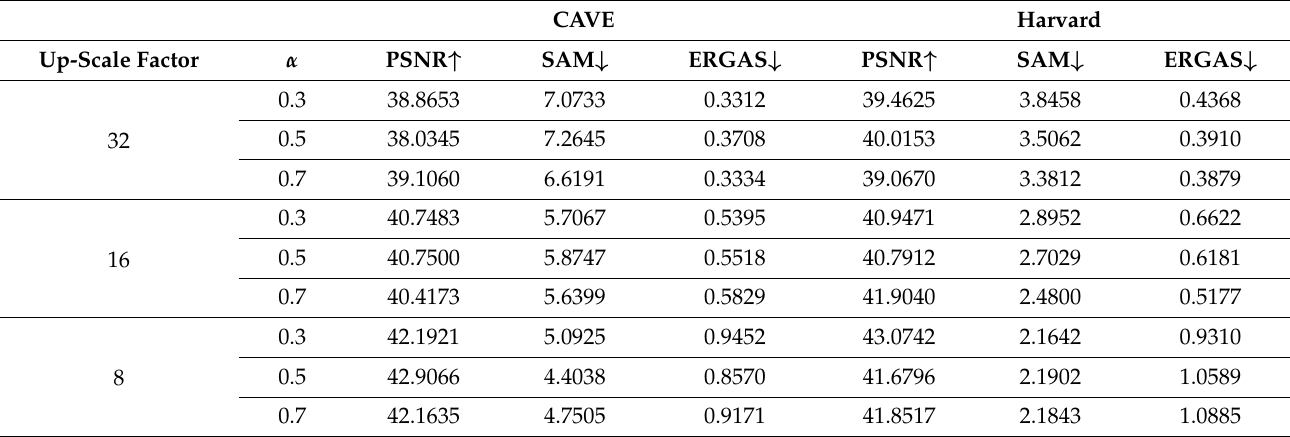
Table 4. Comparison of the evaluation results using our proposed method: DUFL+ with different weights α values of 0.3, 0.5 and 0.7 in the CAVE and Harvard datasets for up-scale factors of 16 and 8. Bold values indicate the best